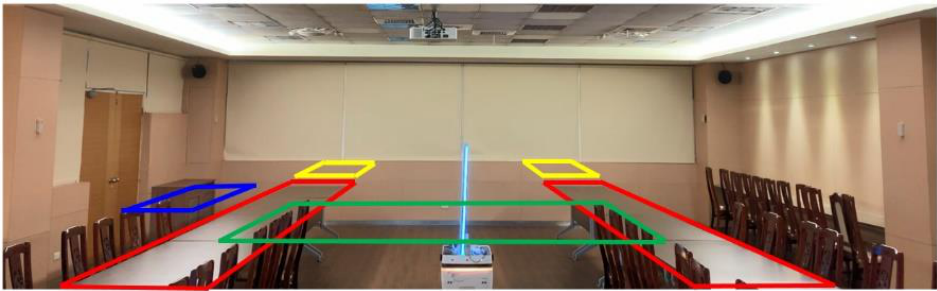
Figure 9. The disinfection vehicle and the environment of the experiment.